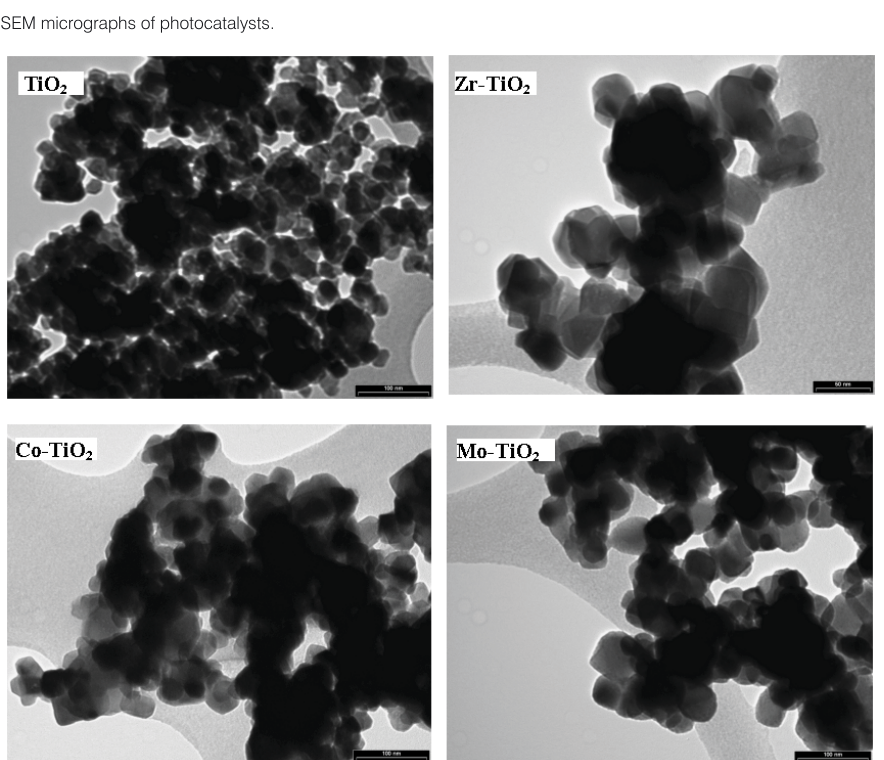
Figure 2. SEM micrographs of